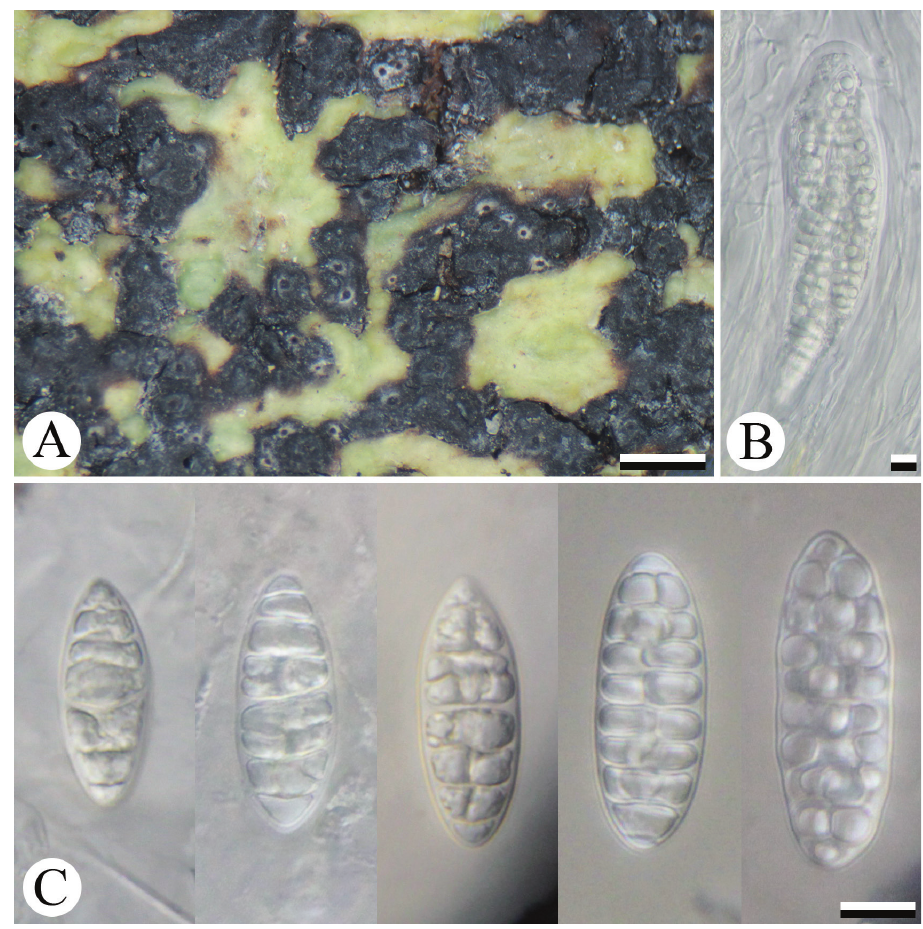
Figure 2. Morphological characters of Architrypethelium murisporum (holotype): A thallus and pseudos- tromata with ascomata B ascus with ascospores and C ascospores. Scale bars: 1 mm ( A ); 10 μm ( B–C